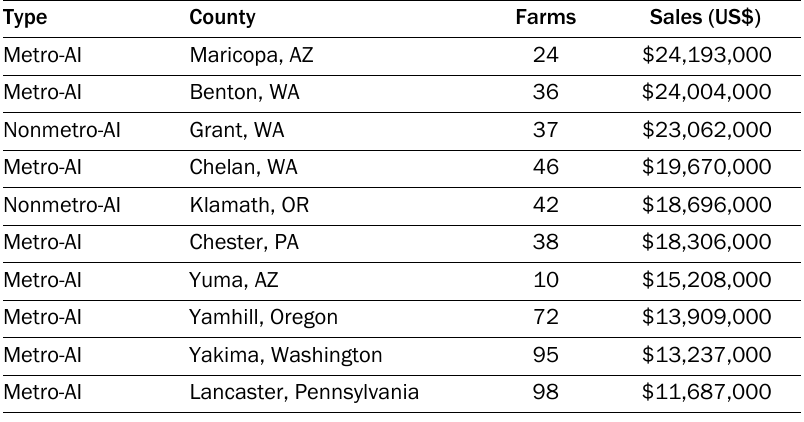
Table 7. Top 10 Counties with Organic Sales Excluding California,